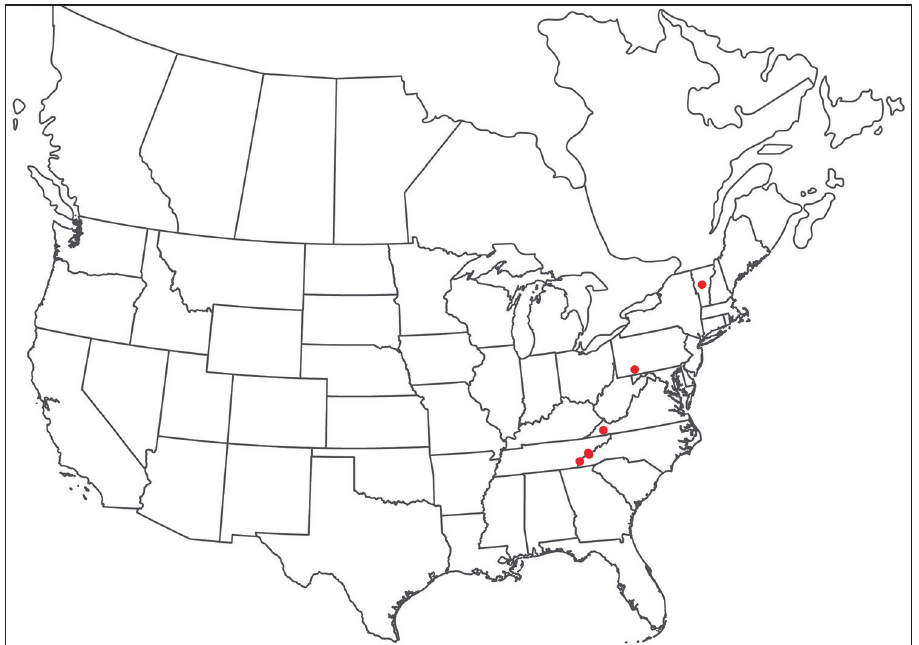
Figure 237. Torrenticola shubini sp. n.